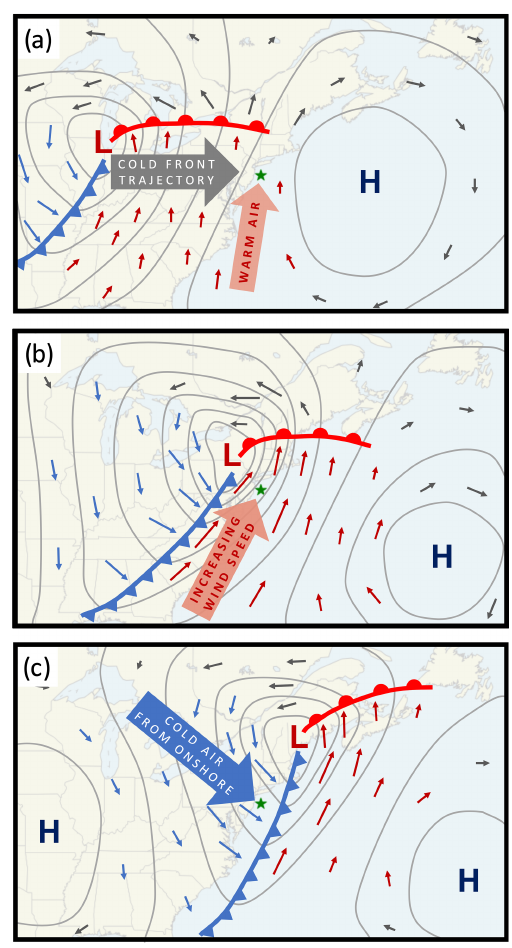
Figure 14. A simplified schematic of the synoptic conditions for high-shear events at the beginning (a) , during the event (b) and as the event ends (c) . Gray lines represent theoretical isobars; arrows pointing to the floating lidars (green star) represent typical wind directions, speed and air temperature; and L and H represent low- and high-pressure centers,